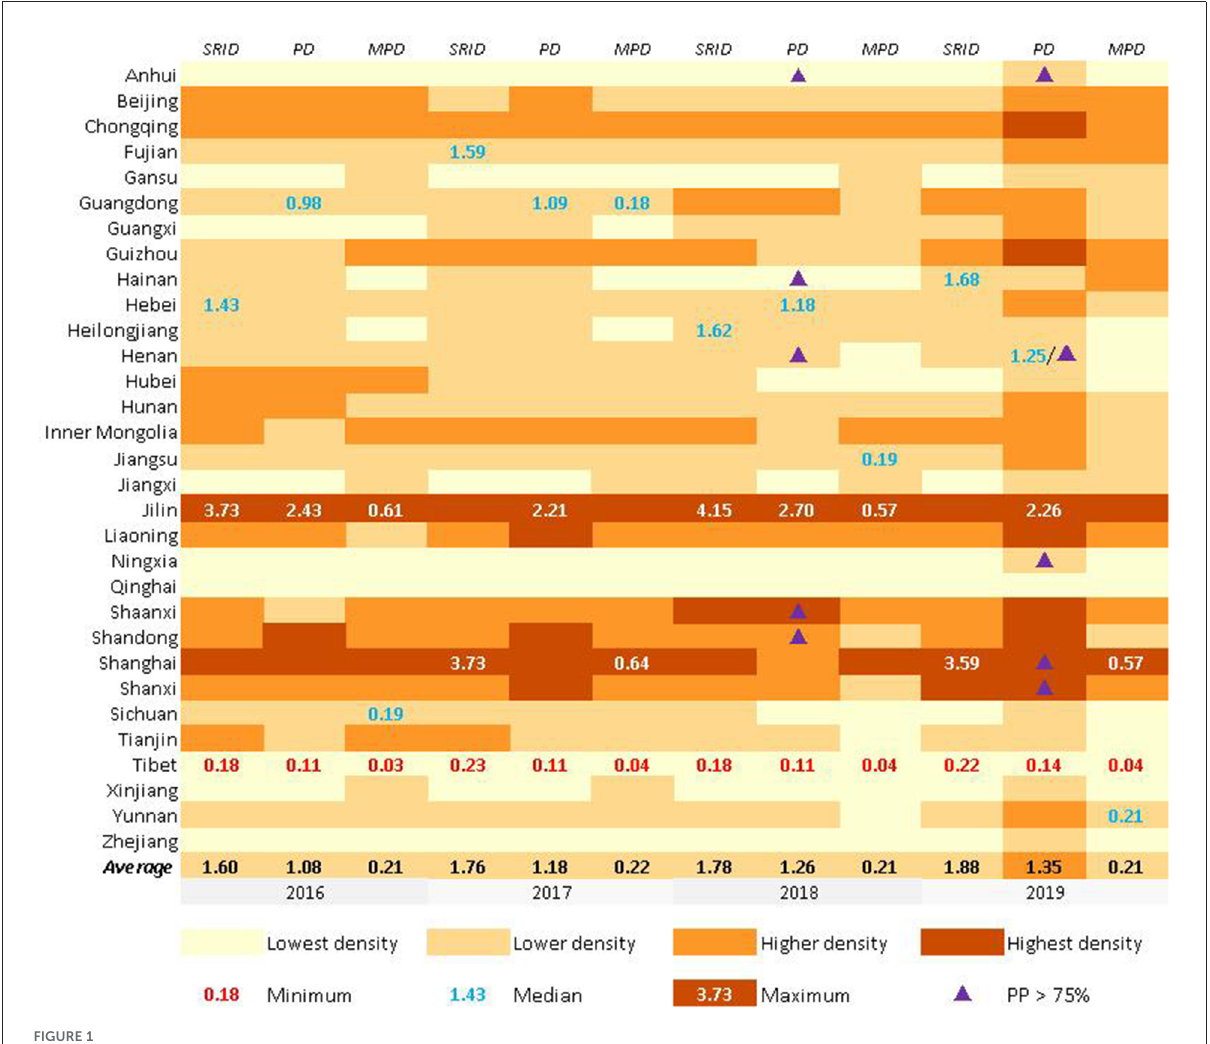
FIGURE1 The density of rehabilitation staffs and from 2016 to 2019 in